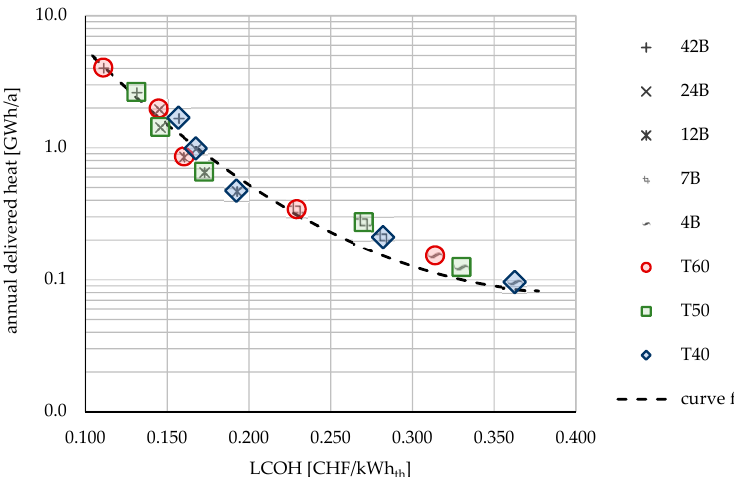
Figure 32. LCOS for each configuration and charging temperature.